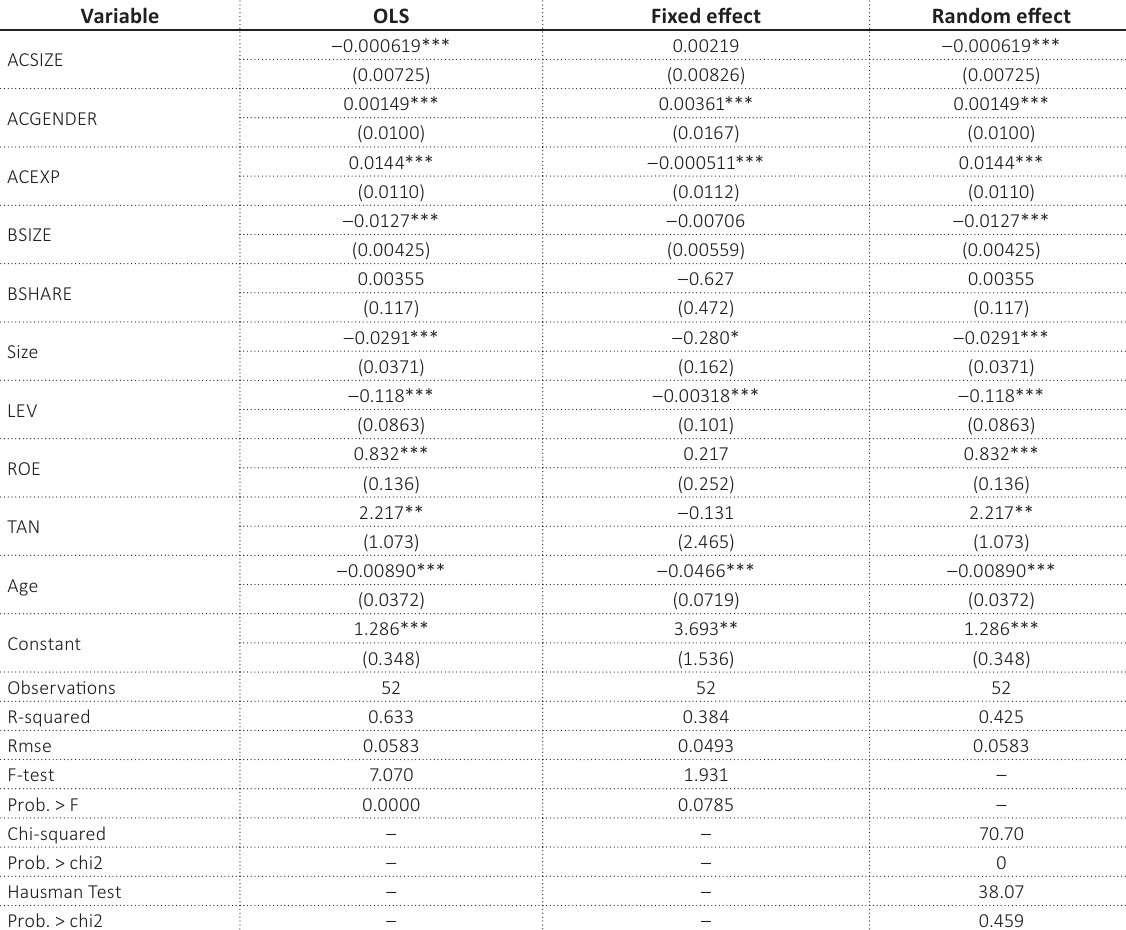
Table 4. Effects of audit committee and board attributes on market